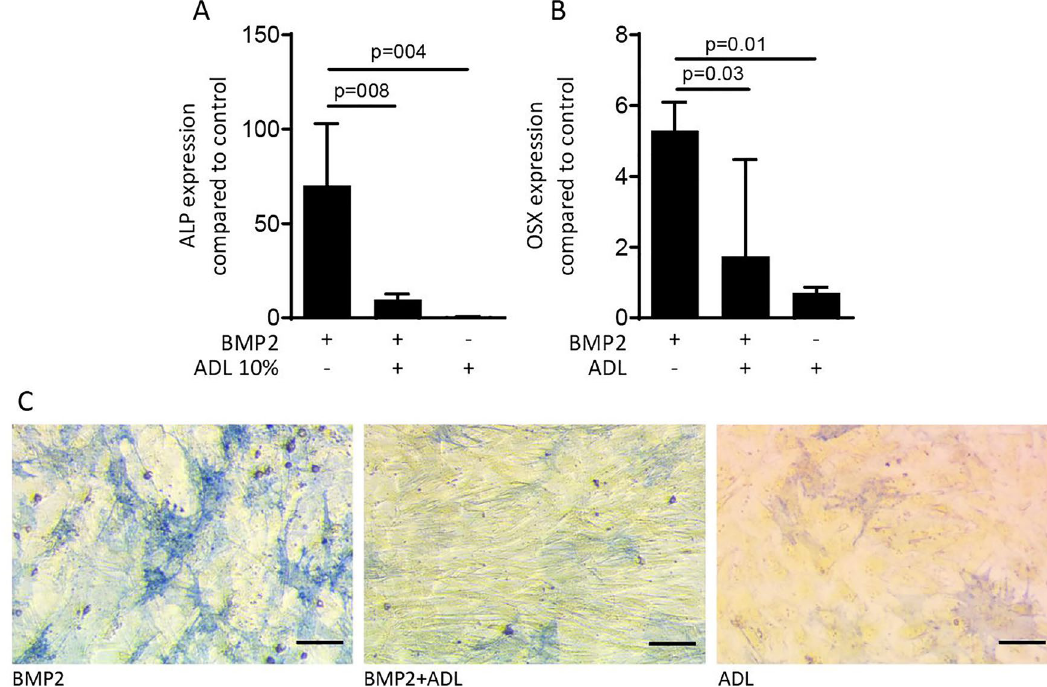
Figure 8. ADL decreases osteogenic differentiation of murine calvaria cells. Exposure of osteogenic calvaria cells to ADL caused a considerable decrease of the osteogenic marker genes ( A ) alkaline phosphatase (ALP) and ( B ) osterix (OSX). This was further confirmed by ( C ) the reduction of ALP staining induced by BMP2. N = 3–5. Data represent the mean ± SD, by Kruskal–Wallis test. Scale bars indicate 100